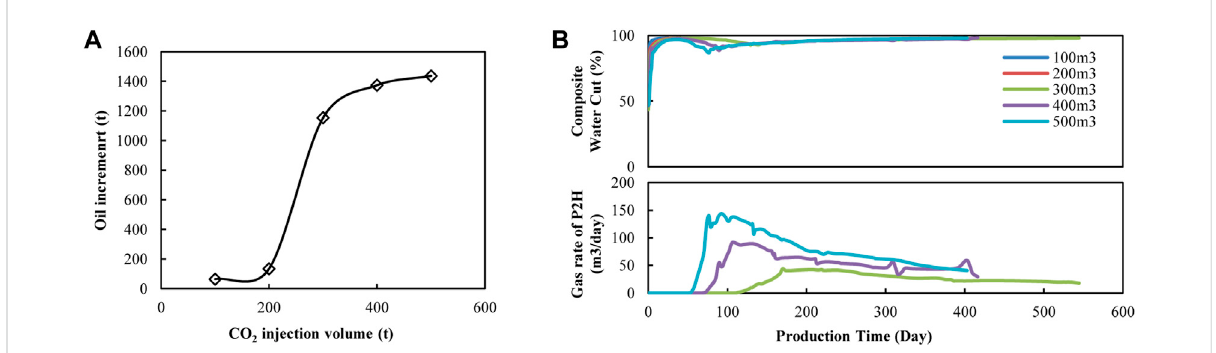
FIGURE 11 Production performance of different CO 2 injection volumes for the well-to-well interplay of CO 2 huff-n-puff. (A) Oil increment vs . CO 2 injection volume. (B) Composite water cut and production gas rate vs . time.